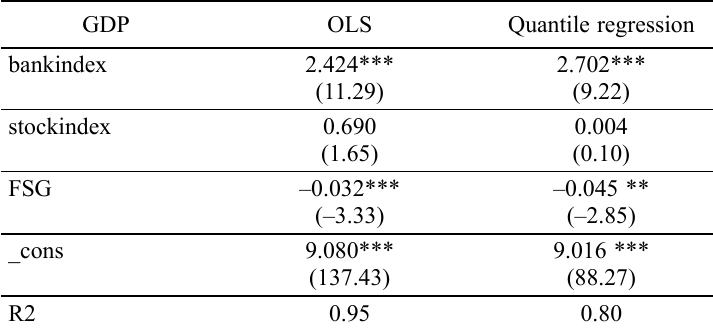
Table 7. OLS & quantile regression estimates of financial structure